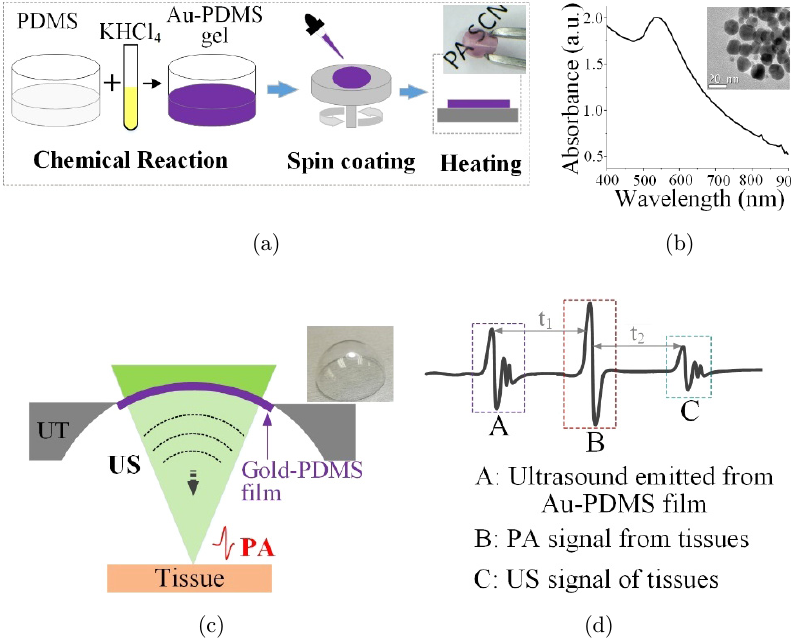
Fig. 1. Gold-PDMS ¯lm synthesis and schematic diagram of simultaneous PA/US imaging. (a) Synthesis process of the gold- PDMS ¯lm. (b) The optical absorption spectrum of the gold-PDMS gel. Inset is the TEM of the gold-PDMS gel. (c) Schematic diagram of simultaneous PA/US imaging based on a gold-PDMS ¯lm. UT: the ultrasonic transducer. (d) Time-resolved schematic diagram of PA and US